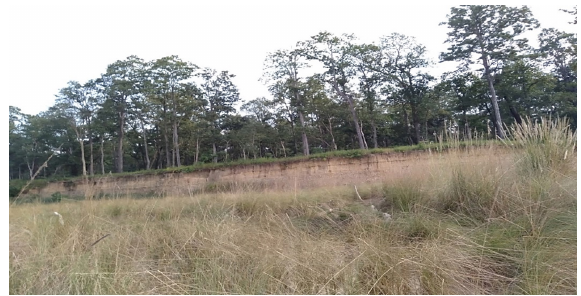
Figure A2. Photograph of an incision of the Karnali River. In the outcrop a loamy layer is positioned on top of a more sandy layer containing rounded pebbles, cobbles and boulders. Sal forest can be seen on top of the cliff. On the right-hand side of the image tall grasses grow amongst the grasses classified in this study as short grassland. The cliff marks the spatial extent of fluvial disturbances of the Karnali River. The difference in elevation is largest in the north of the study area and gradually decreases southwards along the interface of riverine and Sal forest. The photograph was taken by the